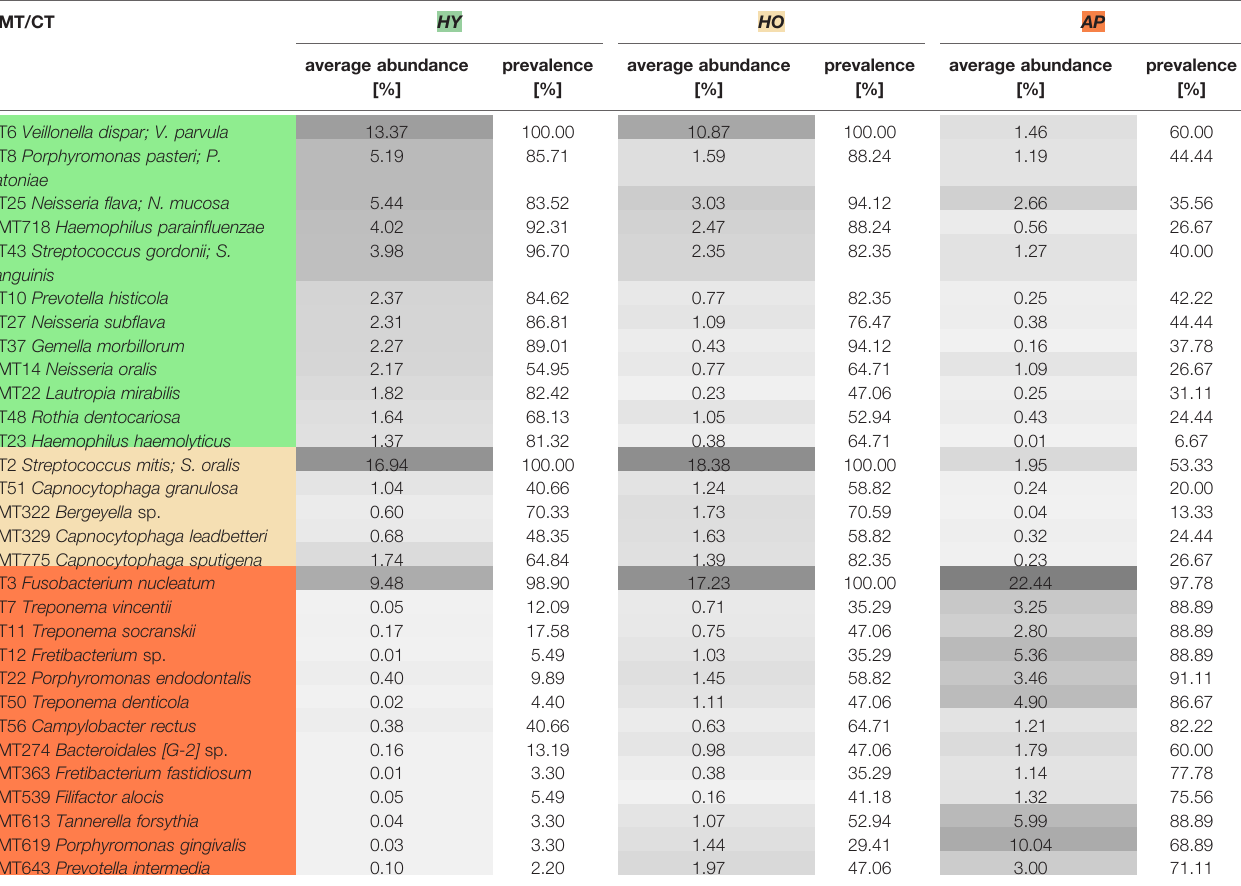
TABLE 2 | The comparison of the relative abundance and prevalence of signi fi cant oral taxa according to the age (HY vs HO) and state of health (HY, HO and AP).